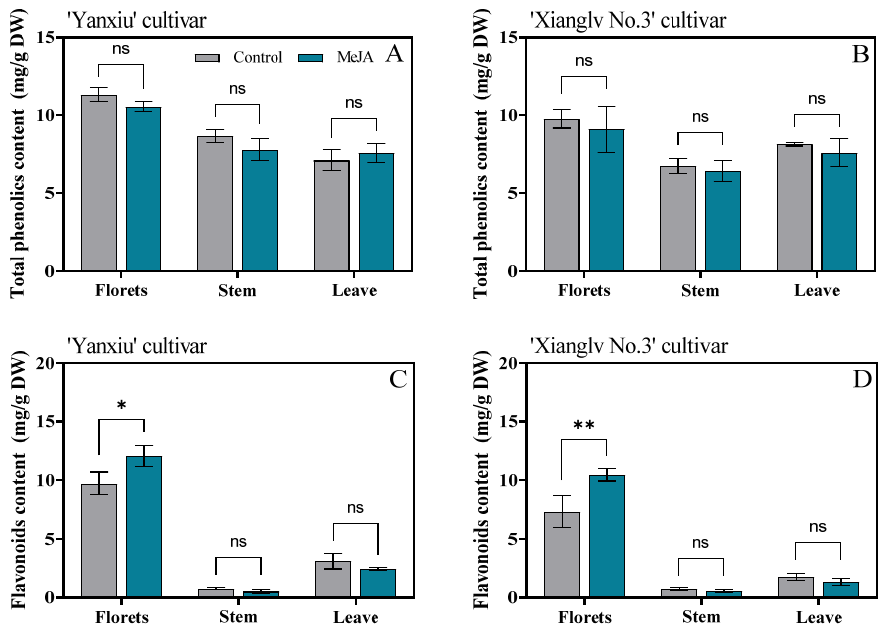
Figure 4. Effects of MeJA on total phenolics ( A , B ) and flavonoids content ( C , D ) in broccoli florets, stem, and leaves. DW: dry weight; Control: the plants were sprayed with distilled water; MeJA: the plants were sprayed with 40 µ mol/L MeJA. The data are displayed with the mean ± SD of three replications. Values with ns, * and ** are significantly different at p > 0.05, p < 0.05 and p < 0.01.